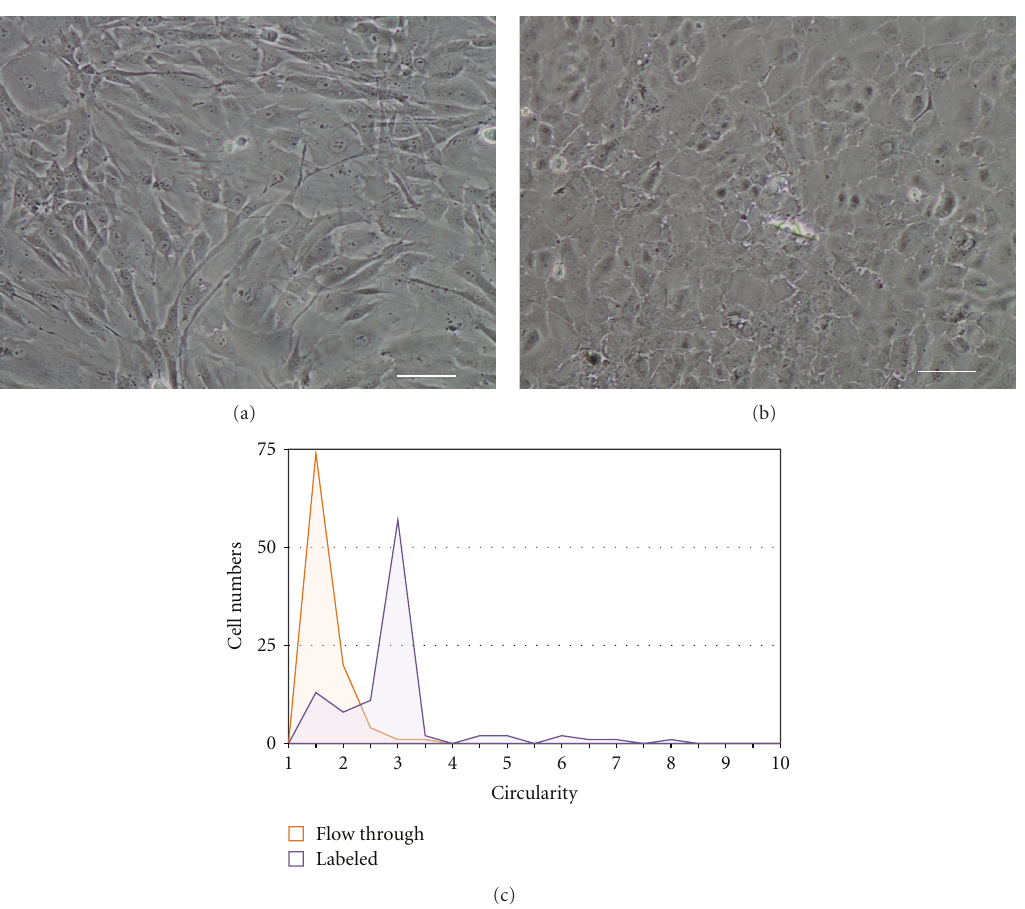
Figure 3: Following MACS of experimentally mixed human corneal endothelial cells and corneal stromal fibroblast using antifibroblast magnetic microbeads, cell fractions were subcultured as (a) the antifibroblast magnetic microbeads “labeled” fraction and (b) unlabeled “flow-through” fraction, 3 days after sorting. (Scale bar = 100 μ m.) (c) A frequency histogram depicting the circularity of randomly selected cells in the “labeled” and the “flow-through” fractions. At least 100 cells from each fraction were counted.